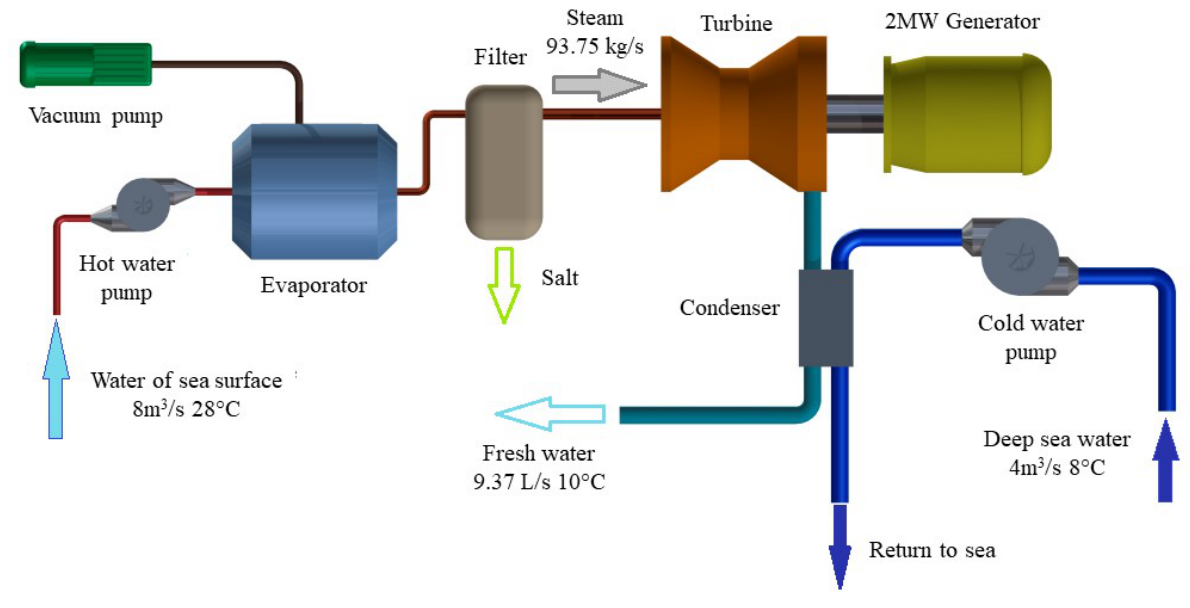
Figure 3. A schematic diagram showing values for an open-cycle OTEC system of 2 MW. Table 4. Operating Specifications for Steam